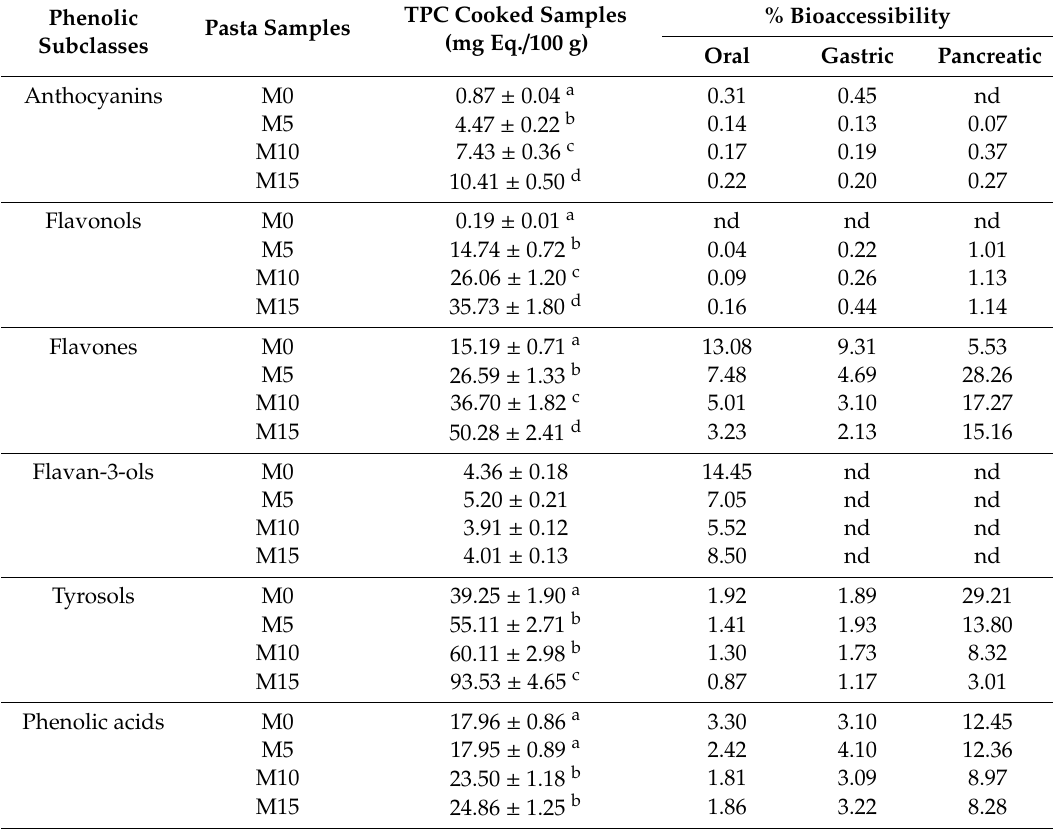
Table 1. Bioaccessibility values (expressed as % of phenolic equivalents) for the di ff erent phenolic subclasses during the in vitro static digestion of the cooked-to-optimum pasta samples formulated with di ff erent substitution levels of Moringa o leifera L. leaf powder (MOLP), considering the oral, gastric, and pancreatic